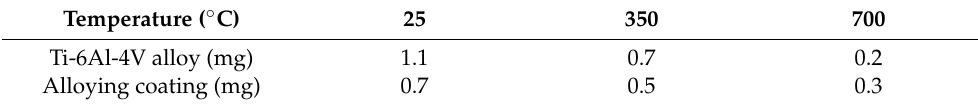
Table 5. The abrasion loss of Ti-6Al-4V alloy and alloying coating at different